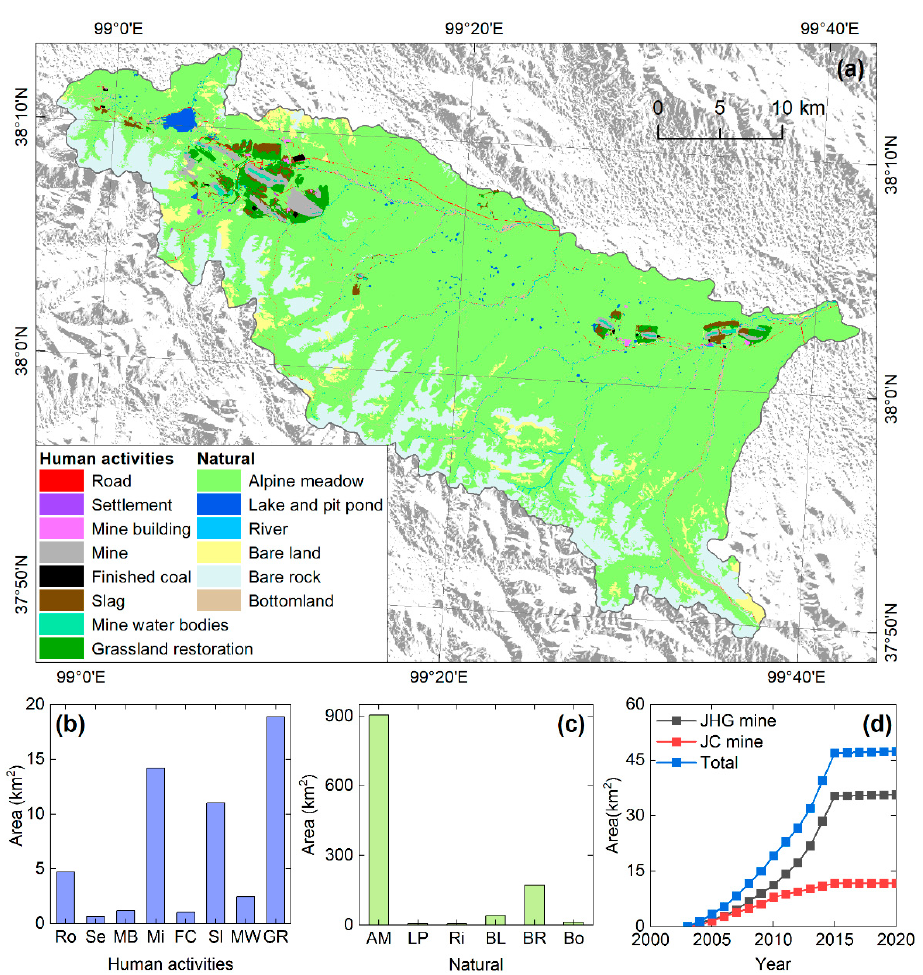
Figure 2. Land use/land cover (LULC) (2020) and mining development (2003–2020) in the Muli region. ( a ) LULC map of the Muli region in 2020; Statistical map of ( b ) human activities and ( c ) natural land in the Muli region in 2020; ( d ) graph of mining development process in the Muli region from 2003 to 2020. Notes: Ro: road; Se: settlement; MB: mine building; Mi: mine; FC: finished